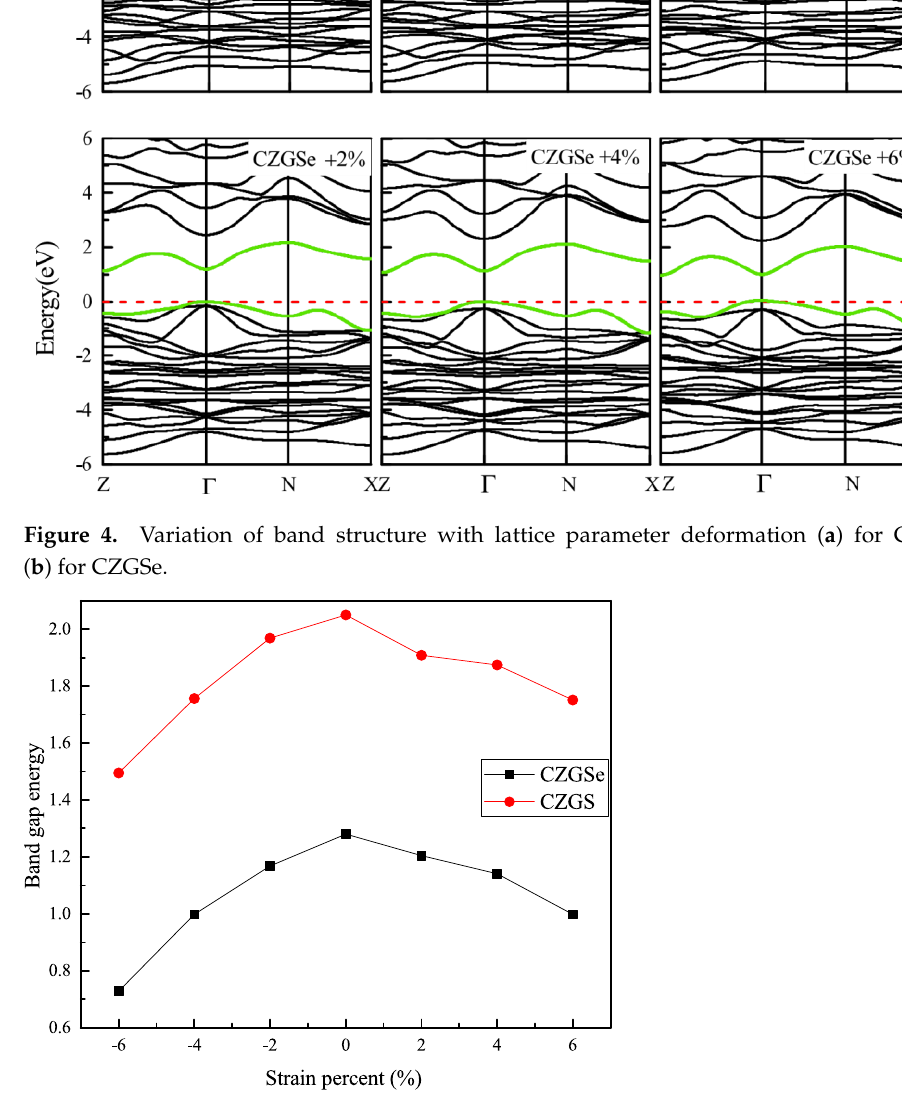
Figure 5. The variation of band gap energy under tensil and compressive biaxial